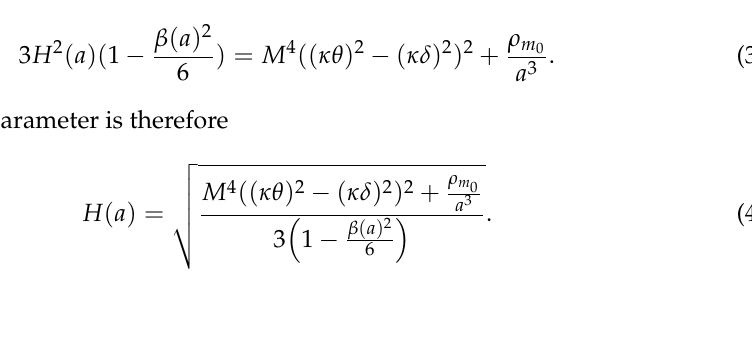
2 − β ) . Equation (14) 0 6 0 (cid:113) ( w + 1 ) , making V 3 Ω θ 0 0 0